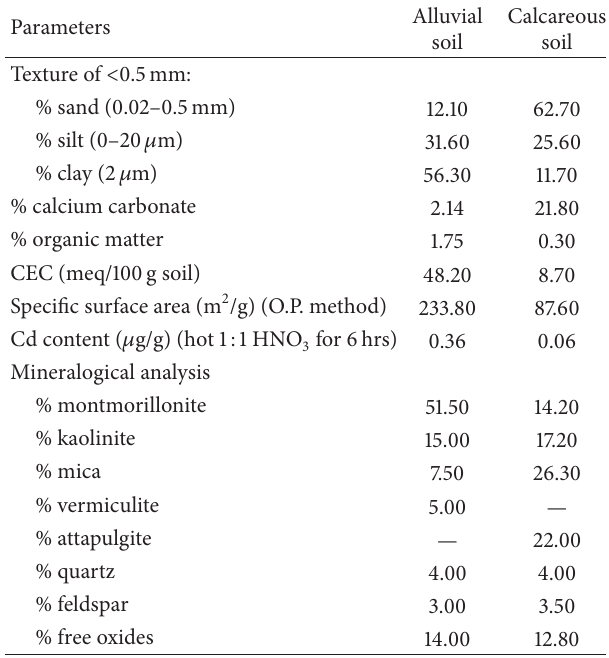
Table 1: Characteristics and mineralogical analysis of the experi- mental soils. Parameters